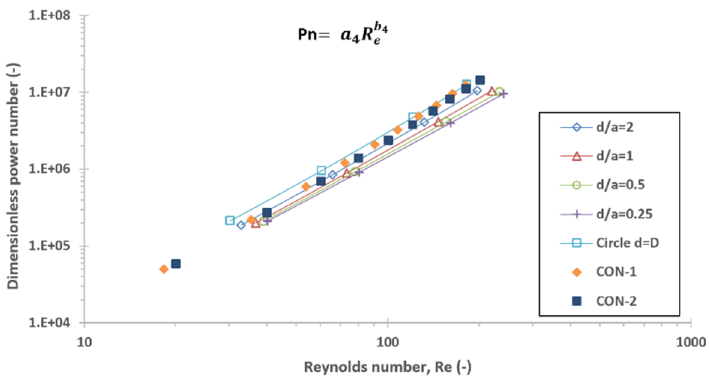
Figure 11. The dimensionless power number, associated with the connecting filament diameter, as a function of the Reynolds number. A comparison was made with the dimensionless results of Haaksman et al. [23]. Table 3. The dimensionless power number function parameters.